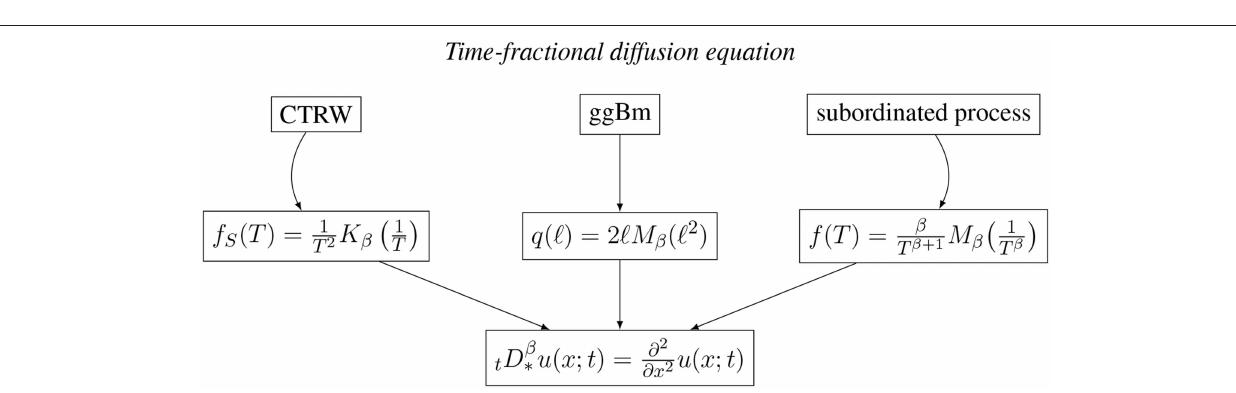
Frontiers in Physics |